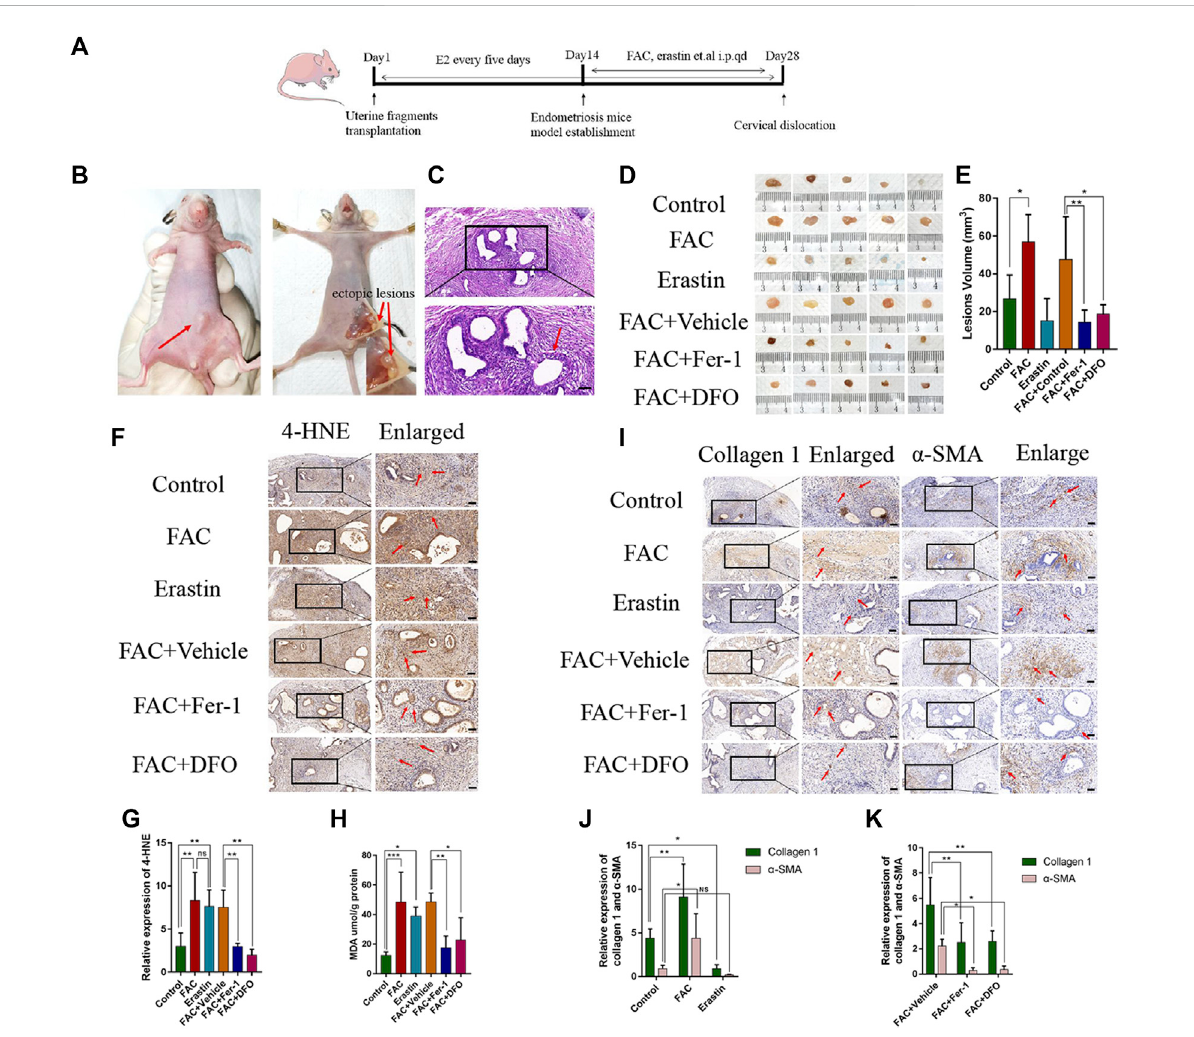
FIGURE 5 EffectsofFAC,erastinandothertreatmentsintheendometriosismicemodel. (A) ProtocoltogeneratetheendometriosismodelinBalb/cnude mice.Balb/cnudemicewereinjectedsubcutaneouslywiththeendometrialtissuesofpeoplewithendometriosisandtreatedwitherastin(15 mg/kg/ i.p. injection), FAC (15 mg/kg/i.p. injection), vehicle, FAC+Fer-1 (1 mg/kg/i.p. injection), FAC+DFO (100 mg/kg/i.p. injection), FAC+vehicle at day 14 onceadayfor2 weeks.TumorvolumewascalculatedonDay28( n =5mice/group). (B) Representativephotographsoftheendometriosismice model and visible nodules growth on day 14 after treatment were shown. (C) HE staining of endometriotic-like lesions to con fi rm the success of the endometriosis model, thetypical endometrioidgland including highlycylindricalepithelium couldbe seen. (D) Macroscopic aspect of visible lesions on Day 28 was different among groups. The volume of ectopic lesions was enhanced after treatment with 15 mg/kg FAC and tend to reduce after treatmentwith15 mg/kgerastinfor2 weeks.Inthecircumstanceofironoverload,Fer-1andDFOreducethevolumeofectopiclesions. (E) Summary data of volume sizes are presented as the mean ± SEM. (F) Representative 4-HNE immunohistochemical results of endometriosis ectopic tissues in each group. FAC-treated group and erastin-treated group revealed higher levels of 4-HNE in comparison to other groups. (G) Quantitative analysis of4-HNEineachgroup. (H) MDAcontentwasassayedusingaLipidPeroxidation MDAAssayKit(Abcam,ab118970).MDAwassigni fi cantlyincreased intheFACanderastin-treatedgroups.Fer-1andDFOcouldreducetheMDAcontent. (I) RepresentativeCollagen1and α -SMAimmunohistochemical results. Fibrosis-related protein immunohistochemical results revealed markedly higher levels of Collagen 1 and α -SMA in the FAC-treated group. In the circumstance of iron overload, the improved effect of iron on endometriosis fi brosis was damaged by treatment with Fer-1 and DFO. (J) Quantitative analysis of Collagen 1 and α -SMA. (K) Quantitative analysis of Collagen 1 and α -SMA. Scale bars: 50 μ m, Signi fi cance in (E,G,H) was calculated using aone-way analysis of variance; Signi fi cancein (J) was calculated using aTWO-way analysisofvariance;* p < 0.05, ** p < 0.01, *** p < 0.001. qd, once a day, i.p., intraperitoneal